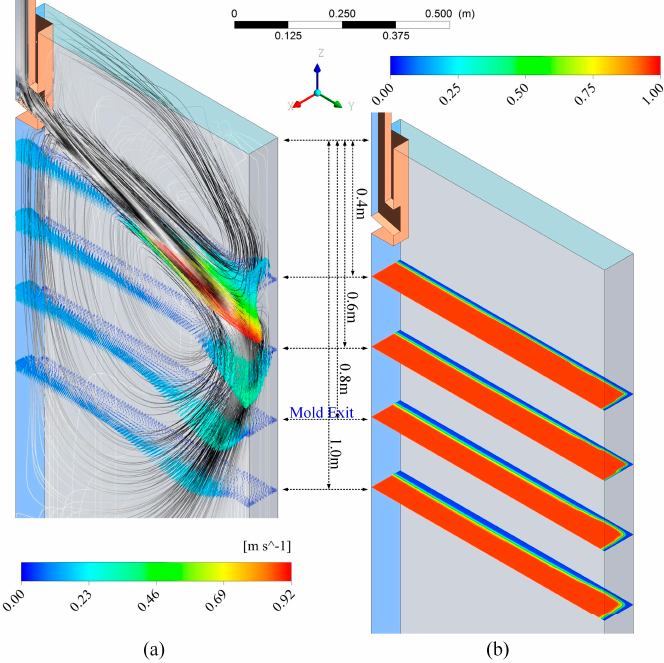
Figure 4. ( a ) Flow field in the turbulent flow region; ( b ) liquid fraction on the different transverse sections.